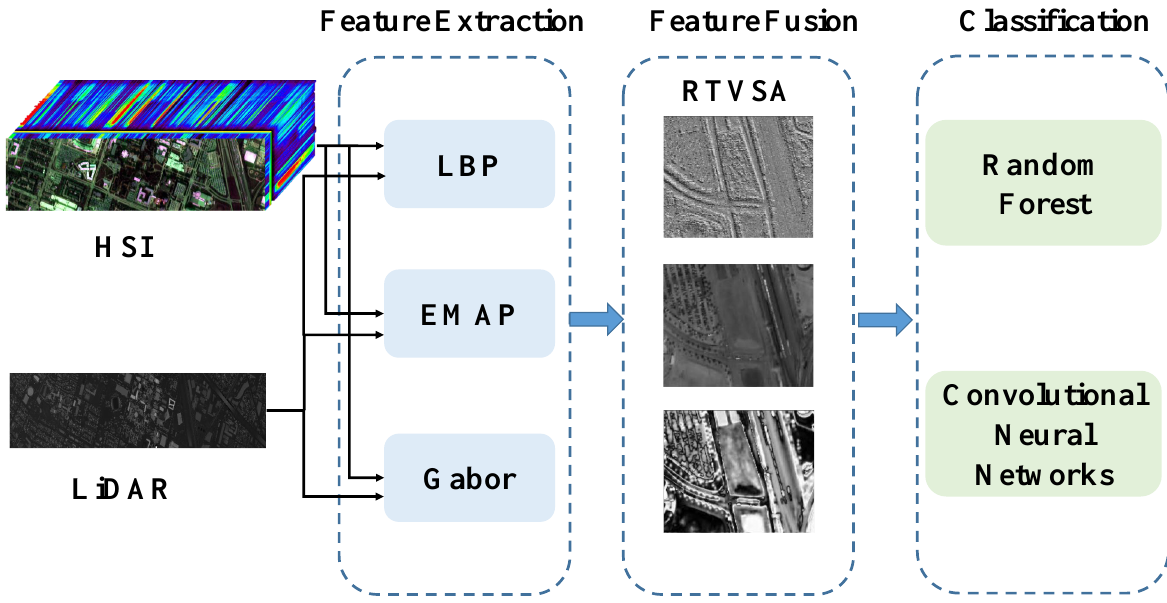
Figure 1. The flowchart of the algorithm design. LBP, local binary pattern; EMAP, extended multi-attribute profile; RTVSA, relative total variation structure